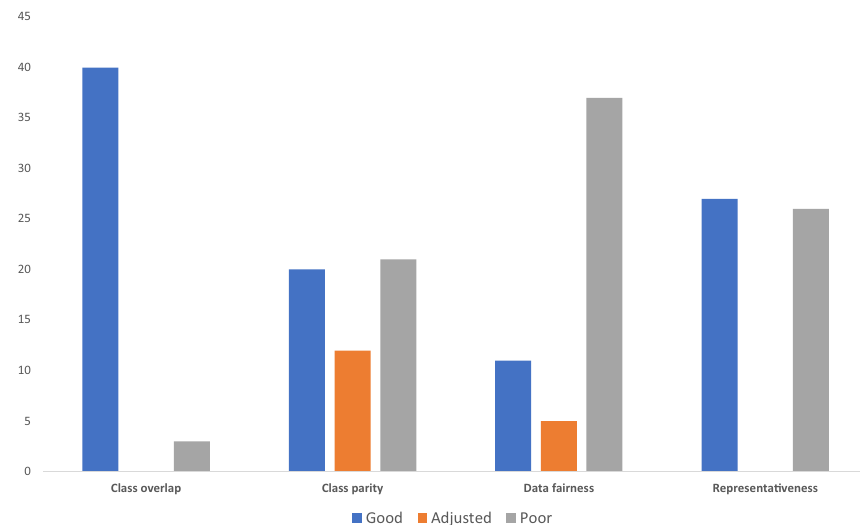
Fig. 5 Distribution of unstructured datasets according to the data quality assessment